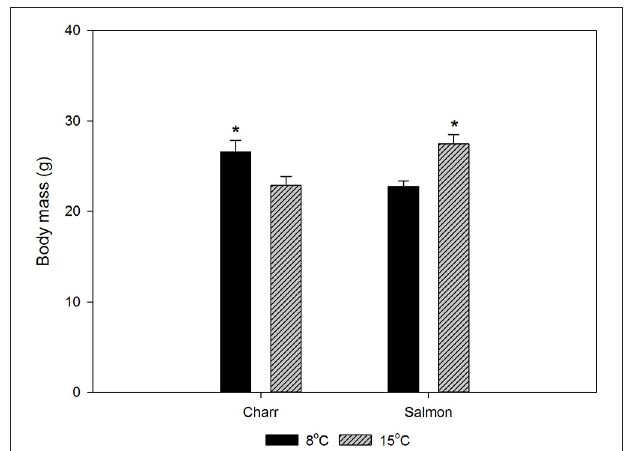
FIGURE 1 | The body masses of Arctic charr and Atlantic salmon after 1-month acclimation to 8 or 15 ◦ C. Before the period of acclimation the fish in each species were held in one patch, so that any differences reflect the effects of acclimation period. Throughout acclimation the fish were fed daily ad libitum . The statistical significance of the difference in weight between 8 and 15 ◦ C-acclimated fish was tested with t -test. p < 0.05 was accepted as a statistically significant effect, indicated with * in the figure, mean ± SEM; N =